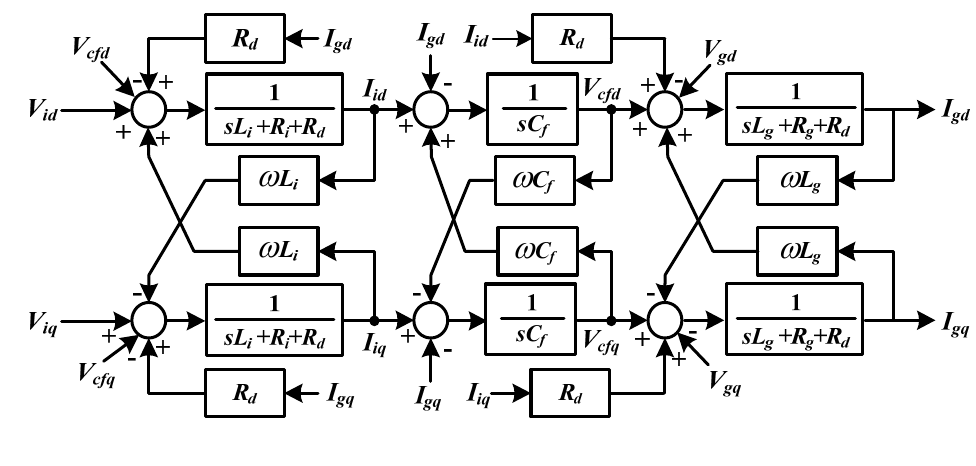
Figure 5. Block diagram of LC filter.